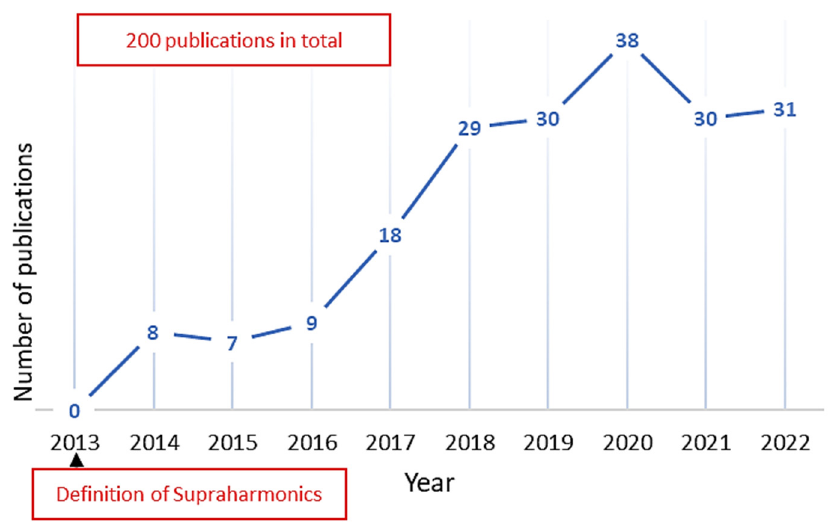
Figure 2. Evolution of the number of publications (blue line) dealing with supraharmonics pollu- tion.